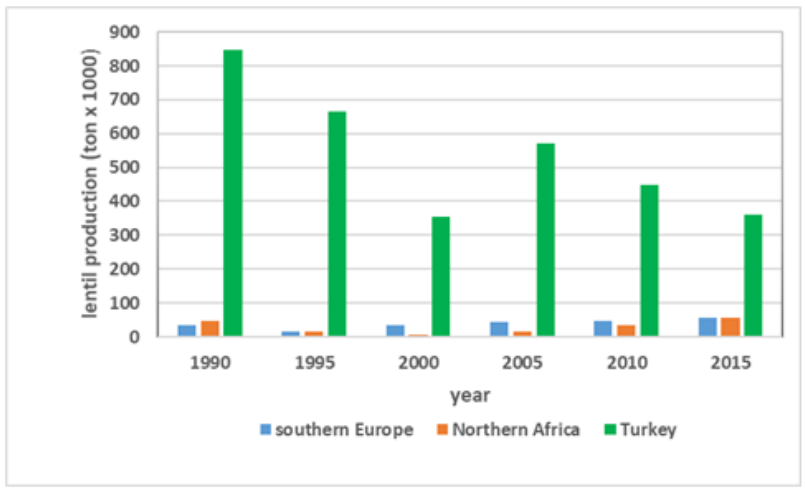
Figure 2. Lentil production from 1990 to 2015 (FAOSTAT). Northern African countries: Algeria, Egypt, Libya, Morocco, Tunisia. Southern European countries: Croatia, France, Greece, Italy, North Macedonia, Portugal, Spain.